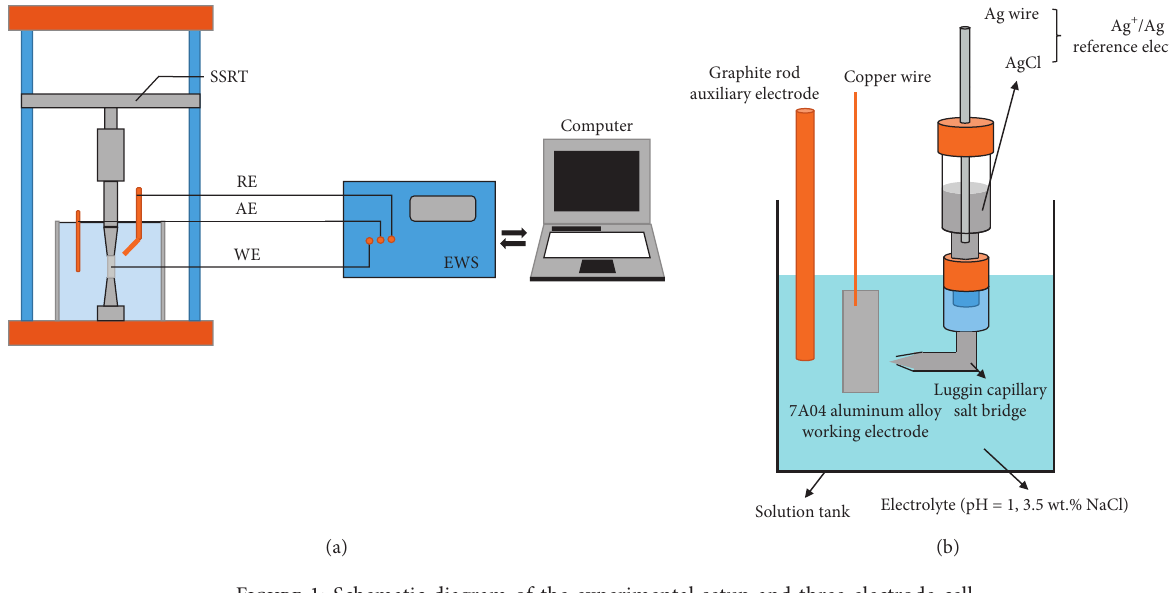
Figure 1: Schematic diagram of the experimental setup and three-electrode